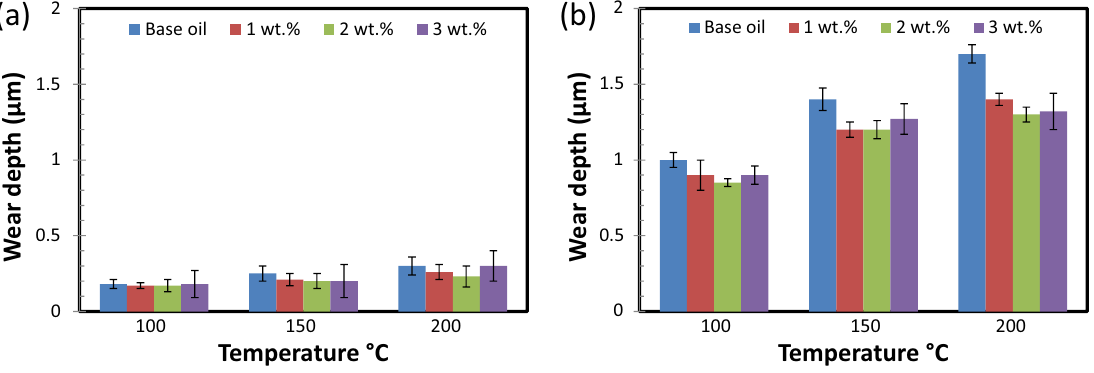
Figure 8: The wear loss of cylinder liner and piston ring specimens: ( a ) wear depth of the nitriding liner specimen and ( b ) wear depth of the PVD - CrN ring